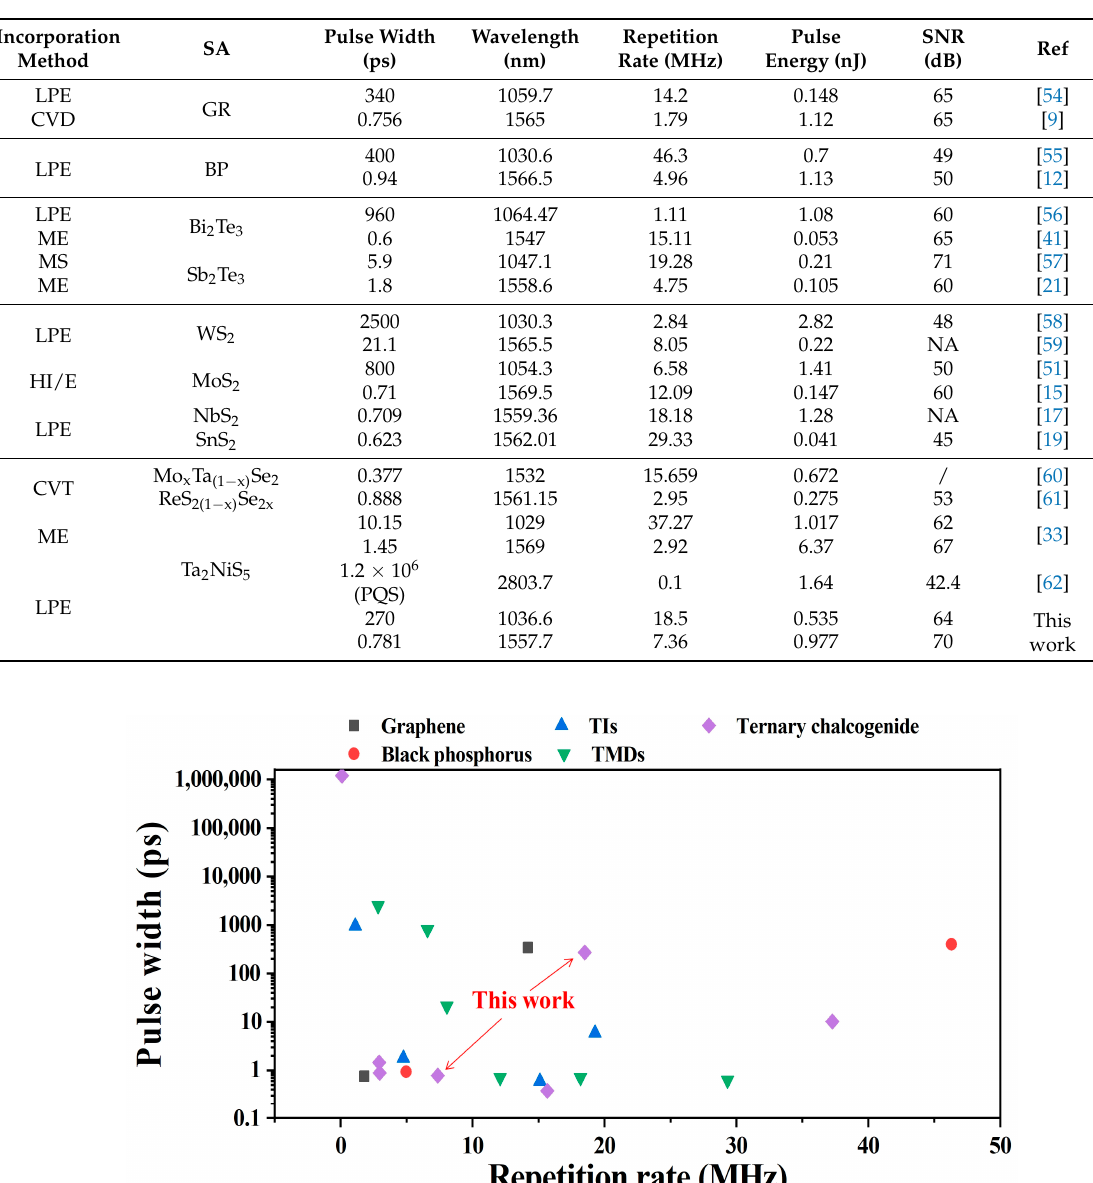
Table 2. Output performance comparison of ML fiber lasers based on various new 2D material-SAs.